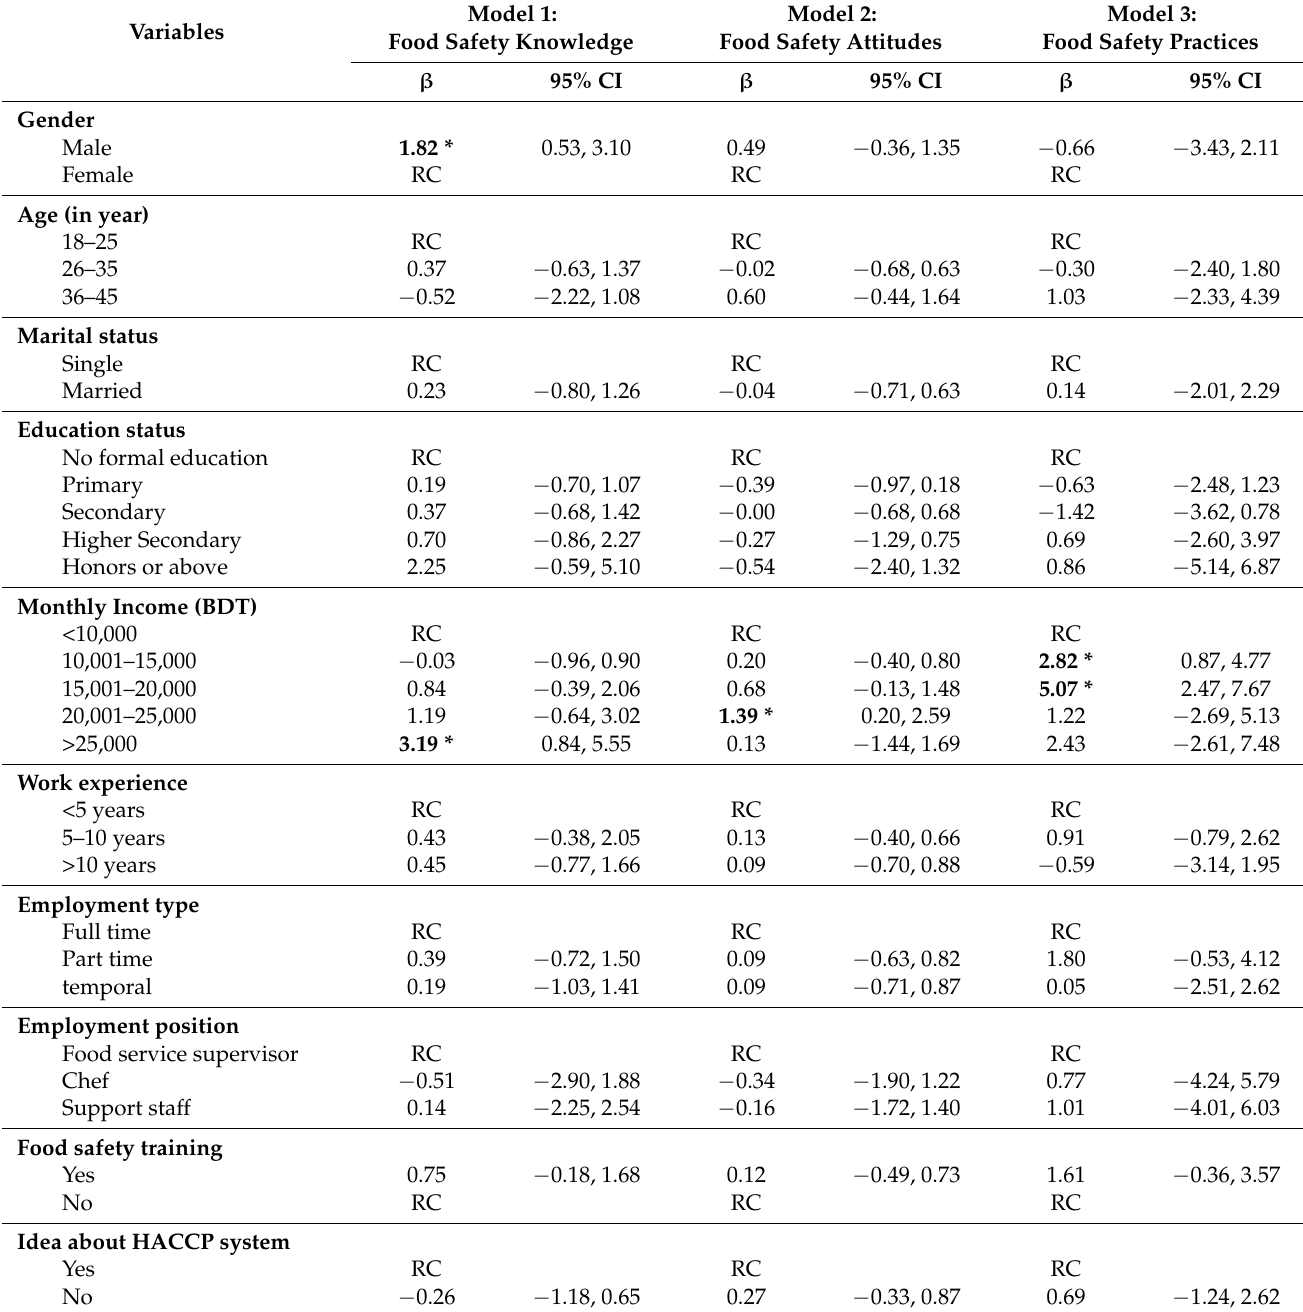
Table 6. Multiple linear regression models identifying the factors associated with food safety knowl- edge, attitudes and practices among study participants (N =